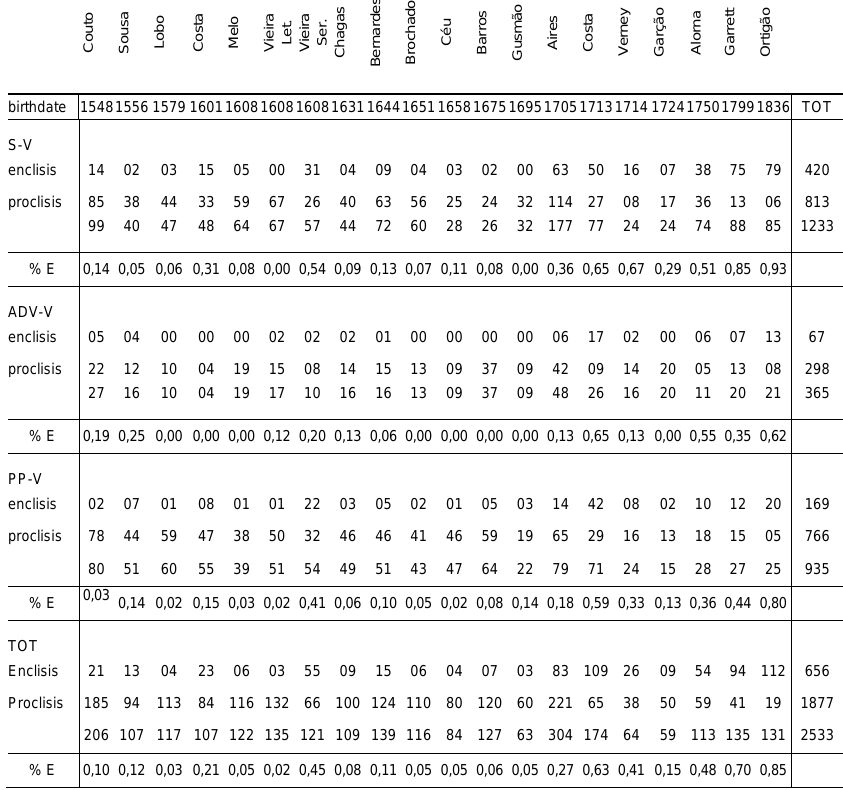
Table 1 : Enclisis Rates in Variation Contexts